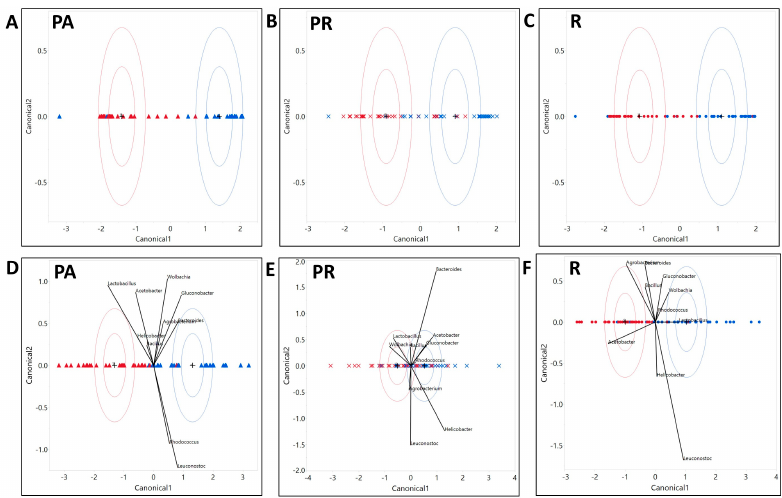
Figure 5. Microbial communities of the larvae raised with or without parental microbiota could be differentiated by the abundance of all bacteria taxa and by the abundance of the dominant taxa only. Discriminant analysis of symbiotic microbiota community based on taxa relative abundances in larvae from non-sterilized (red) and sterilized (blue) treatments. The analysis includes ( A ) All identified ZOTUs on a PA diet ( B ) on a PR diet, and ( C ) on an R diet. On all diets, treatment serves as a good predictor for a differentiation of the symbiotic bacterial communities. ( D ) The 10 dominant genera on a PA diet. ( E ) The 10 dominant genera on a PR diet. ( F ) The 10 dominant genera on an R diet. Treatment serves as a good predictor for the separation of bacterial communities on ( D ) PA and ( F ) R diets and is associated with the dominant bacteria taxa .